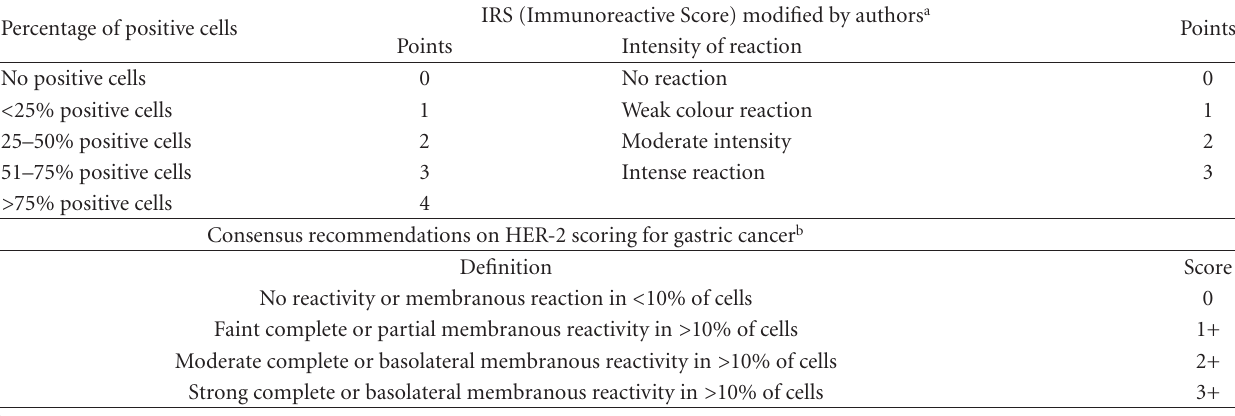
Table 1: Two procedures for evaluation of HER-2 expression.